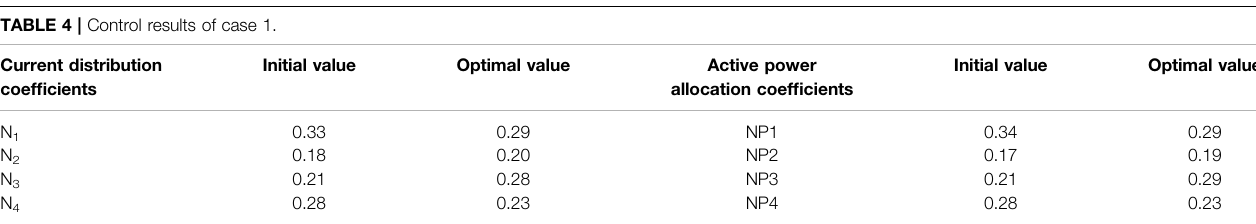
TABLE 4 | Control results of case